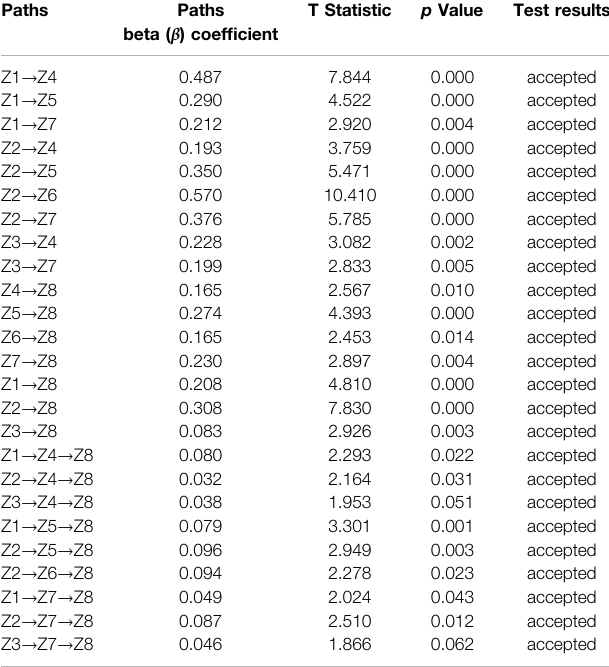
TABLE 7 | Path coef fi cient with mediating variables and signi fi cance test results. Paths Paths beta ( β ) coef fi cient